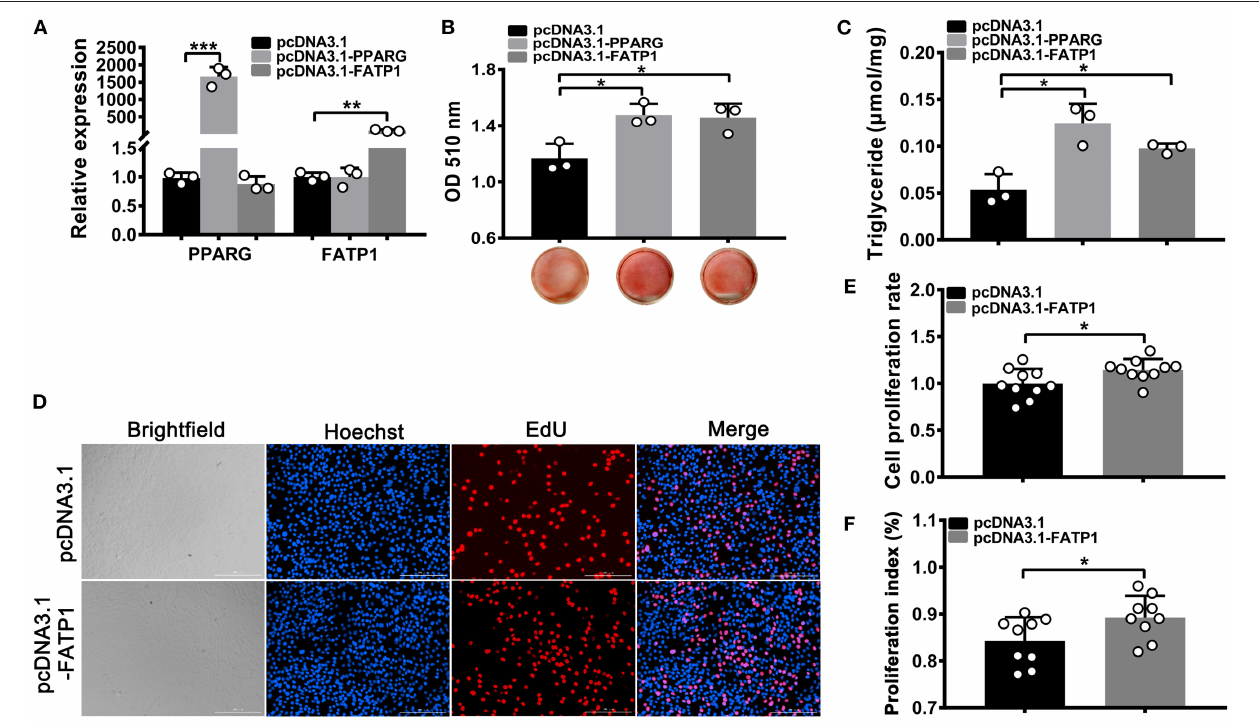
FIGURE 6 | FATP1 enhances the proliferation and promotes the adipogenic trans-differentiation of C2C12 cells. (A) The mRNA expression levels of PPARG and FATP1 as determined by RT-qPCR. (B) Histogram showing the quantitation of oil red O staining. (C) The triglyceride levels of C2C12 cells on day 8 of adipogenic trans-differentiation. (D) Micrographs of the EdU assay in C2C12 cells. Scale bar, 200 µ m. (E) Statistical analysis of EdU assays in C2C12 cells. (F) Statistical analysis of CCK-8 assays in C2C12 cells. Data are presented as means ± SD, * p < 0.05, ** p < 0.01, *** p <